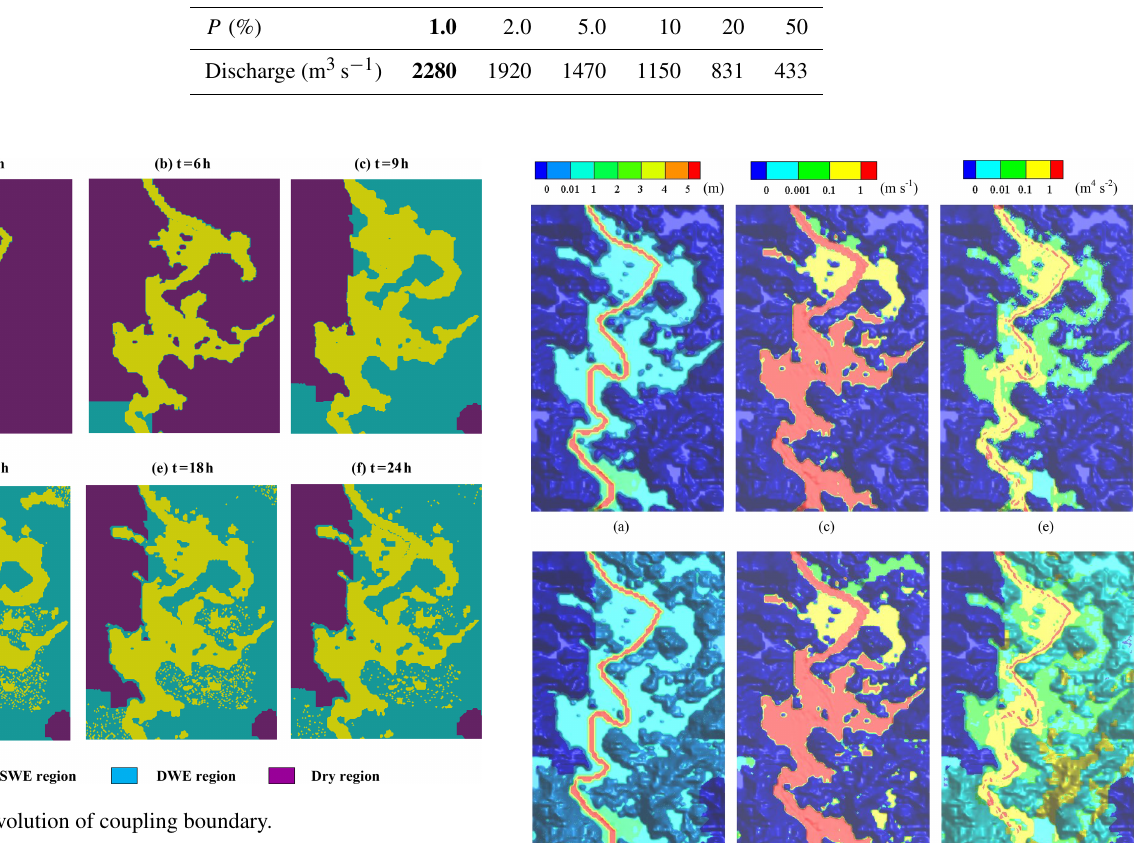
Table 4. Peak discharge at Helin outlet for different flood frequencies. Bold font denotes the values used in the simulation.